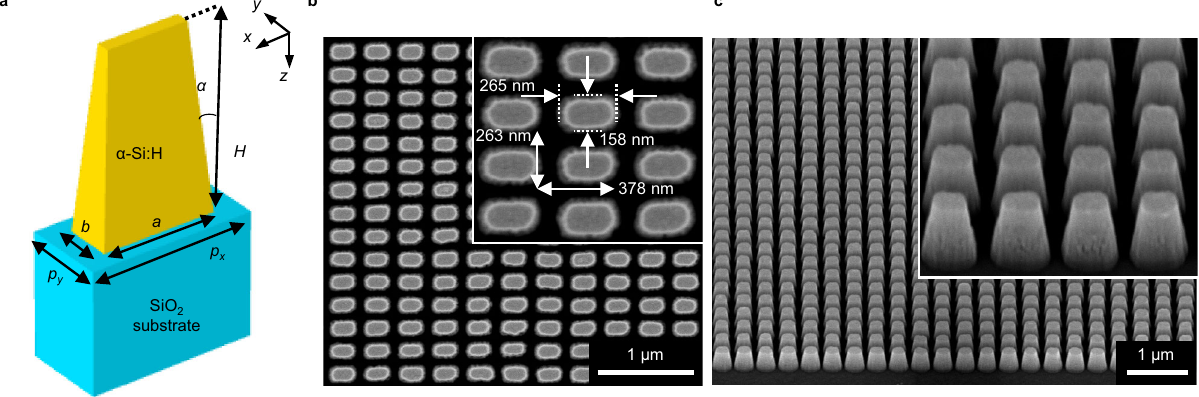
Fig. 2 Design of a dielectric metasurface. a Schematic of a unit cell. Geometric parameters are given as: height H = 400nm, length a = 265 nm, width b = 158 nm, periodicities p = 378 nm and p = 263 nm, and taper angle α . b , c Scanning electron microscopy images of the fabricated sample. b Top view, x y c perspective view. Inset shows a magni fi ed image.